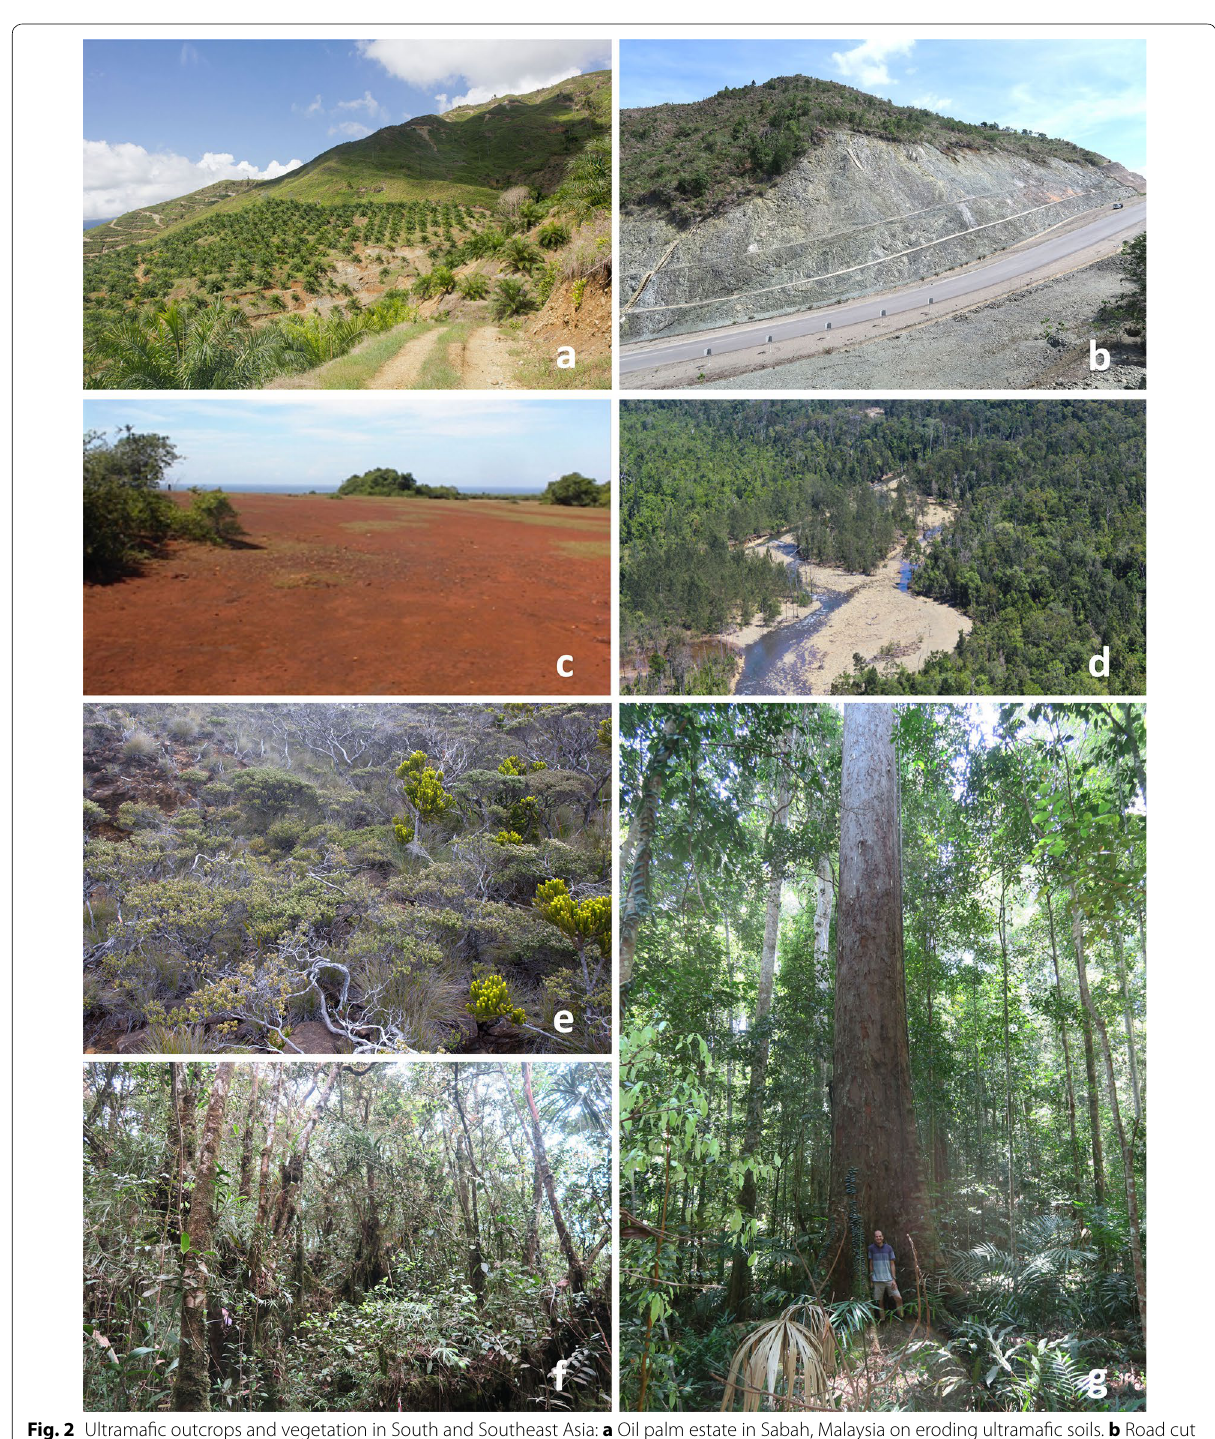
Fig. 2 Ultramafic outcrops and vegetation in South and Southeast Asia: a Oil palm estate in Sabah, Malaysia on eroding ultramafic soils. b Road cut through strongly serpentinised bedrock in Sabah, Malaysia. c Bare red Ferralsols at Ussangoda in Sri Lanka. d River flowing through an ultramafic outcrop in Halmahera, Indonesia. e Extremely stunted sub-alpine vegetation on ultramafic soils in Kinabalu park, Malaysia. f Montane cloud forest on ultramafic soils on Mount Silam, Malaysia. g Exceptionally tall lowland mixed dipterocarp forest on ultramafic soils in Sabah, Malaysia (all images are by A. van der Ent, except c by Y.A.S. Samithri and g by Isabella